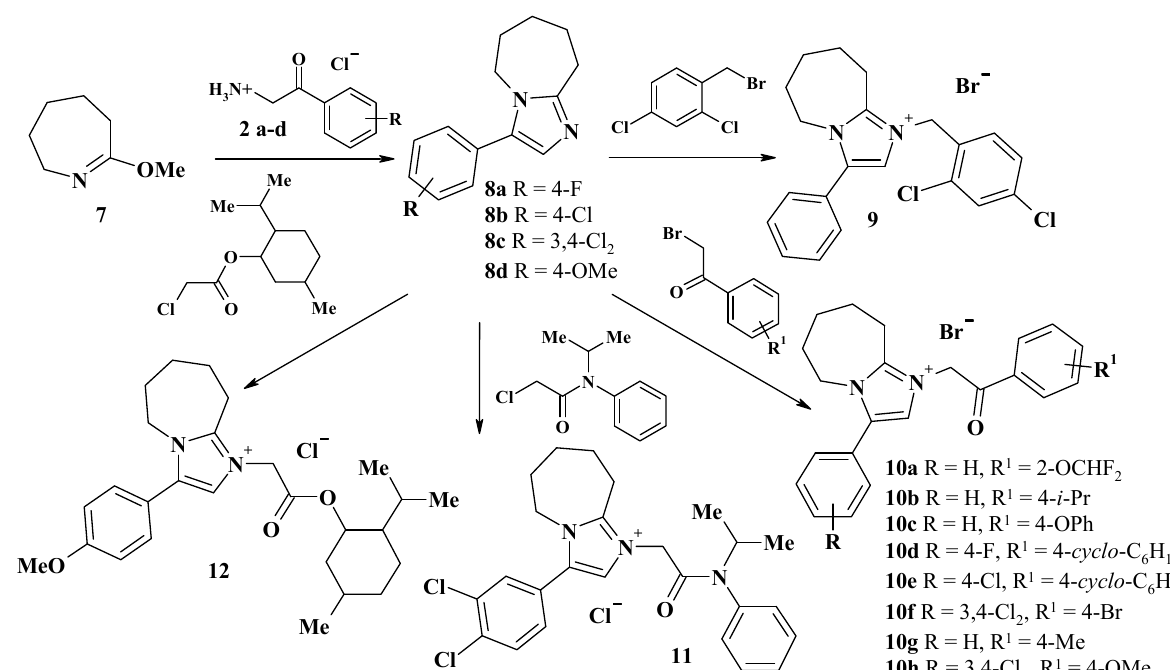
Scheme 1. Synthetic routes for the preparation of compounds 4 , 5, and 6a – e .